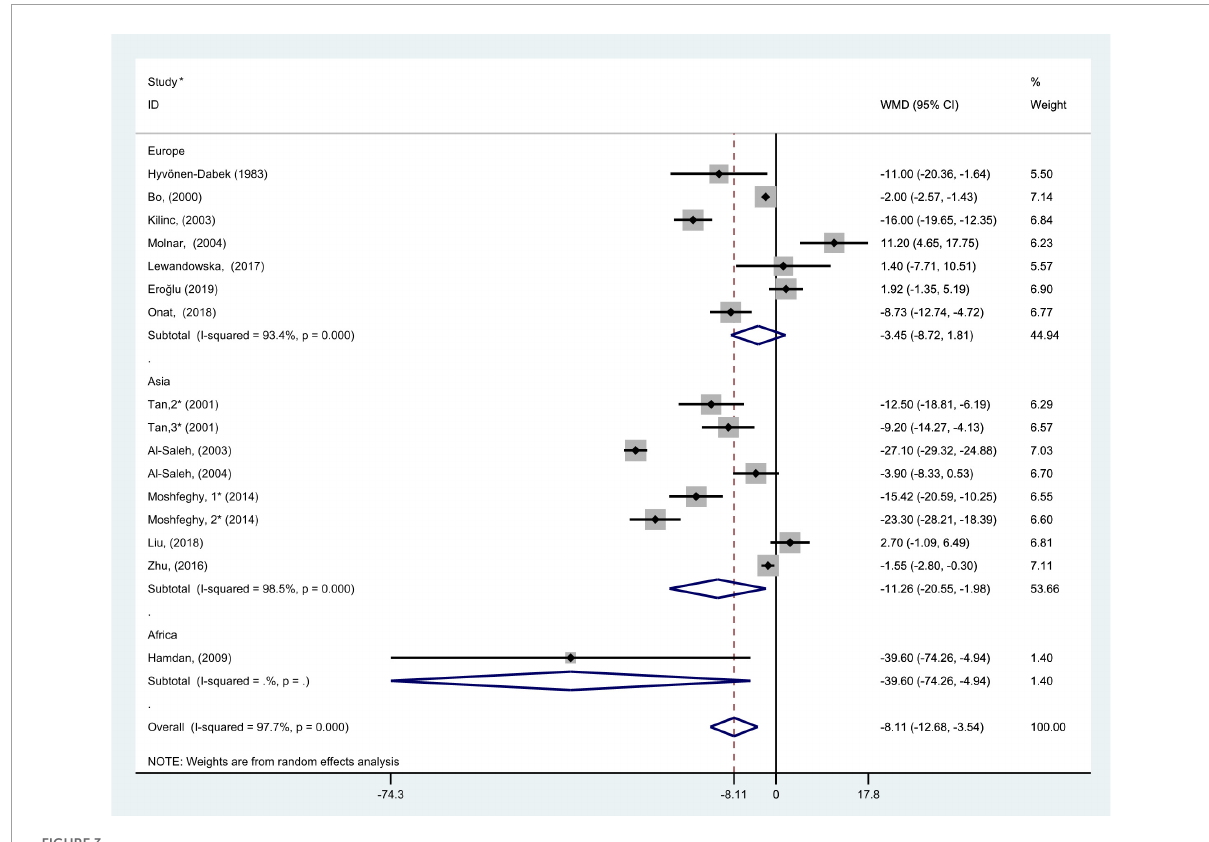
FIGURE3 Subgroup analysis of blood selenium level in patients with gestational diabetes mellitus and healthy pregnant women based on geographic region. The random effects model is applied. For studies in which blood selenium levels were measured during different pregnancy periods in one study, 1, 2, and 3 are used to denote measurements performed in the first, second, and third trimesters, respectively. *First author (year of study